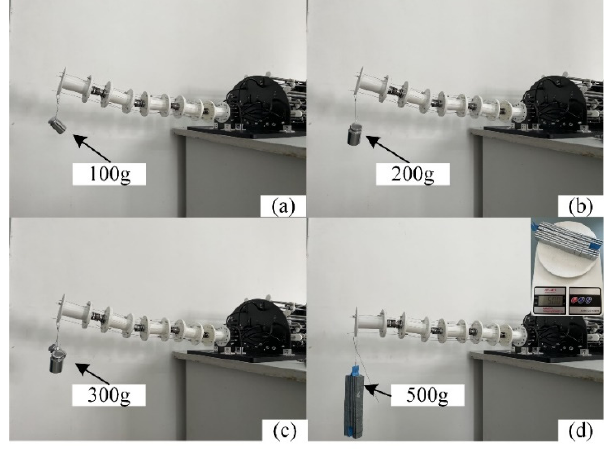
Figure 10. Load experiment ( a ) 100 g of weight, ( b ) 200 g of weight, ( c ) 300 g of weight, ( d ) 500 g of weight.